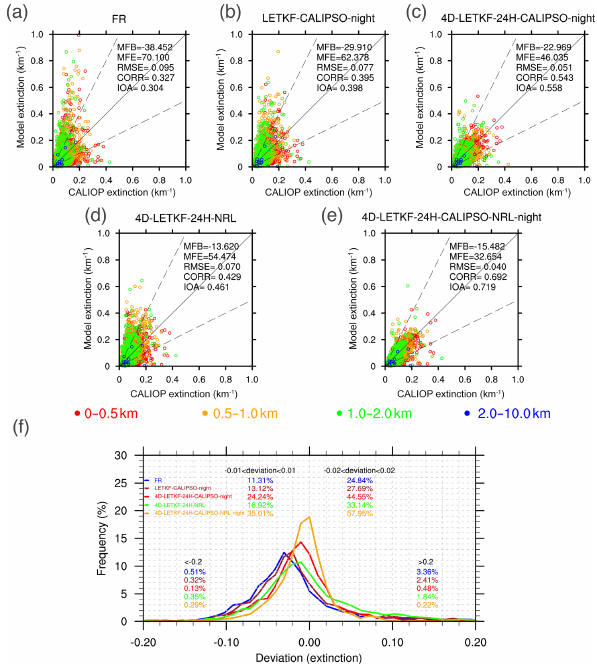
Figure 13. Scatter plots of the simulated hourly aerosol extinc- tion coefficients in the daytime at 550nm (km − 1 ) for the FR (a) , LETKF-CALIPSO-night (b) , 4D-LETKF-24H-CALIPSO-night (c) , 4D-LETKF-24H-NRL (d) , and 4D-LETKF-24H-CALIPSO- NRL-night (e) experiments versus the CALIOP-observed ones in the daytime at 532nm. (f) Frequency distributions of deviations (modeled extinction coefficients minus the CALIOP-observed ones in the daytime). The percentages of deviations between ± 0 . 01, ± 0 . 02, < − 0 . 2, and > 0 . 2 are also shown.